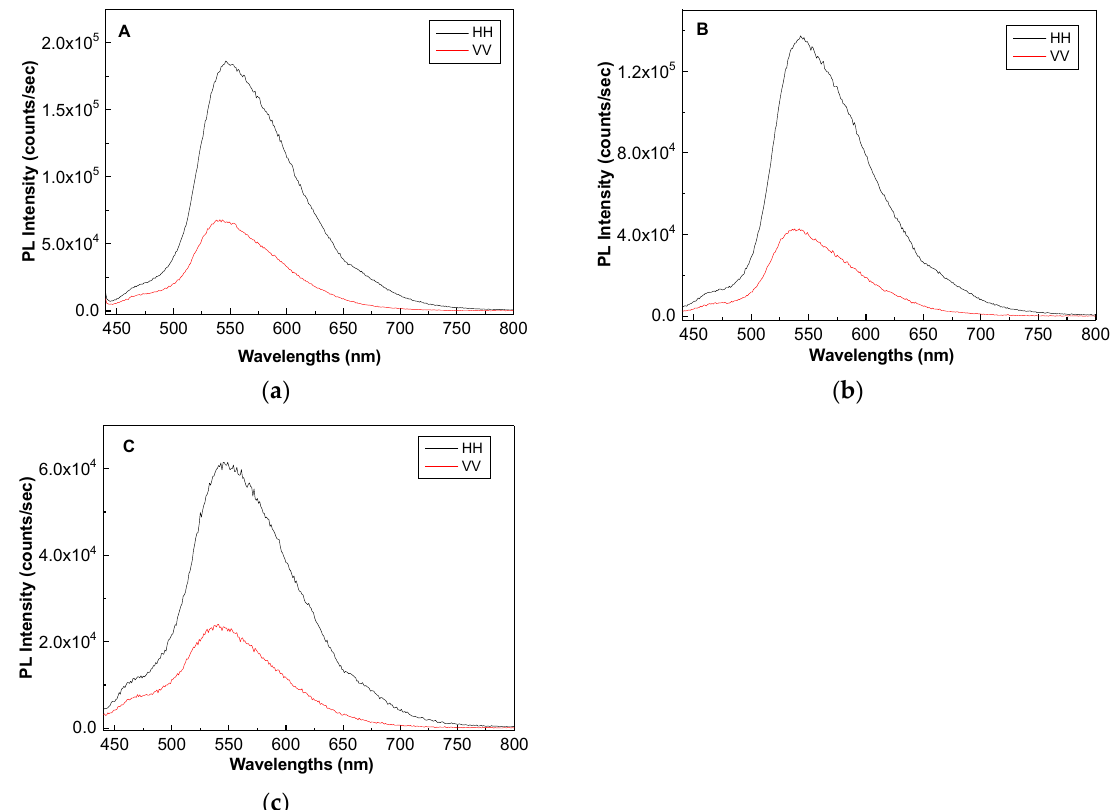
Figure 8. Polarized PL spectra of the POPD-PVDF blends labeled as A ( a ), B ( b ) and C ( c ) samples. All PL spectra were recorded at the excitation wavelength equal to 420 nm.